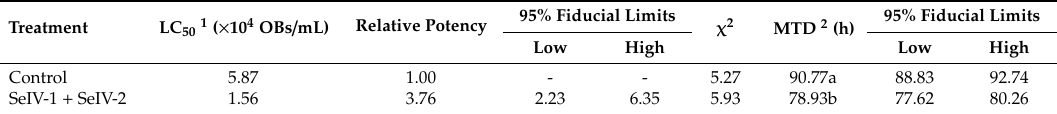
Table 2. LC 50 values, relative potency and mean time to death (MTD) for S. exigua second instars inoculated with SeMNPV viral occlusion bodies (OBs) on either a mock-infected control group or a group that hatched from SeIV-1 + SeIV-2-treated egg